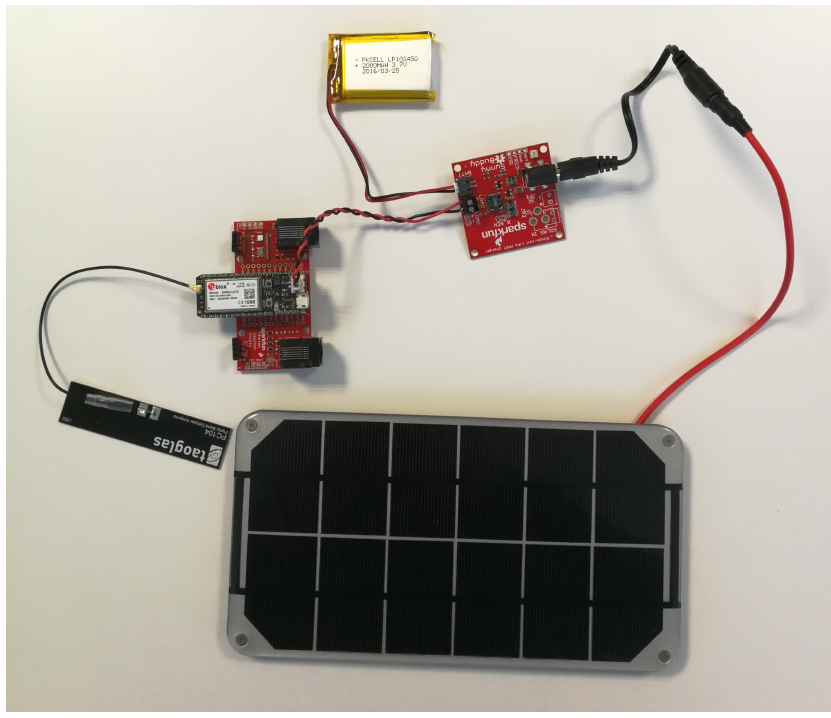
Figure 5. The different components used to build the Core Power supply and Communication groups.